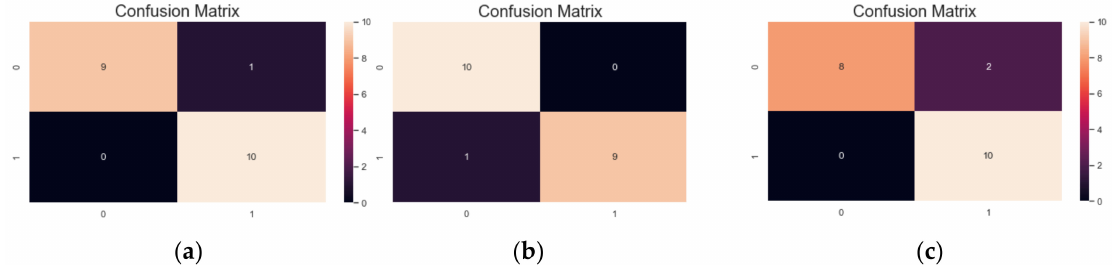
Figure 19. The confusion matrices of recognition results using a three-layer CNN model on the test images belong to similar image groups: ( a ) G1, ( b ) G2, and ( c )